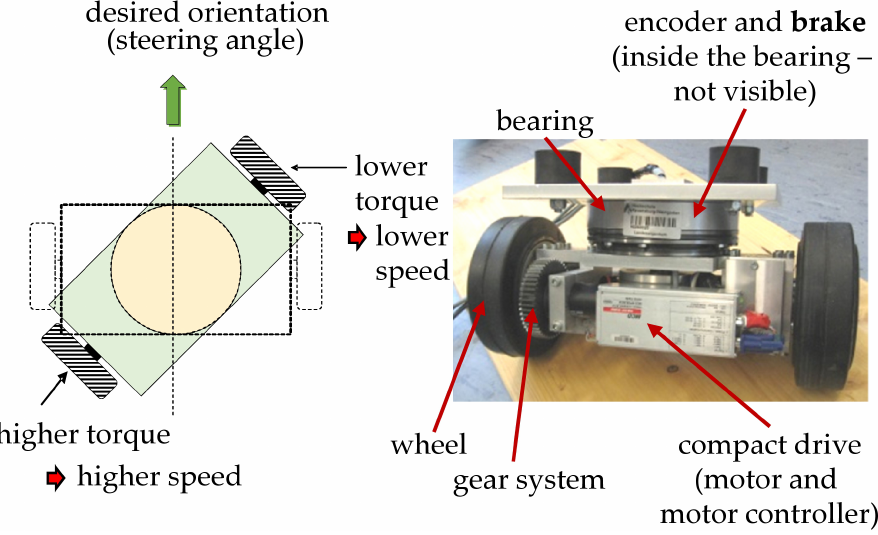
Figure 5. Drive module of the AGV—torque steering and certain